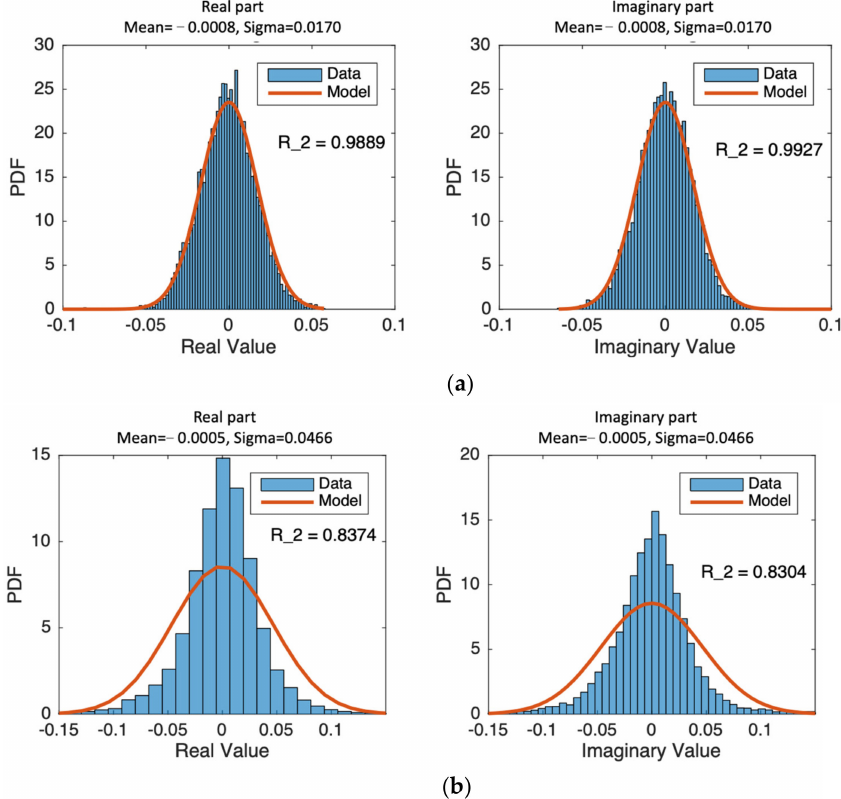
Figure 6. PDFs of Real and imagery parts of SLC images, ( a ): Gaussian HPD surface; ( b ) Weibull HPD surface. The surface RMS height is 0.39 λ , correlation length is 1.56 λ , with look angle of 70 ◦ . Next, we plotted R 2 coefficients for ten samples of SLC images amplitude PDFs of Gaussian and Weibull HPD surfaces, both with exponential PSD, as shown in Figure 7. The Gaussian surface has higher and more stable R 2 coefficients than the Weibull surface, indicating that the Gaussian surface tends to be more Rayleigh model. The non-Gaussian surface, or the Weibull in this case, substantially deviates from Rayleigh.